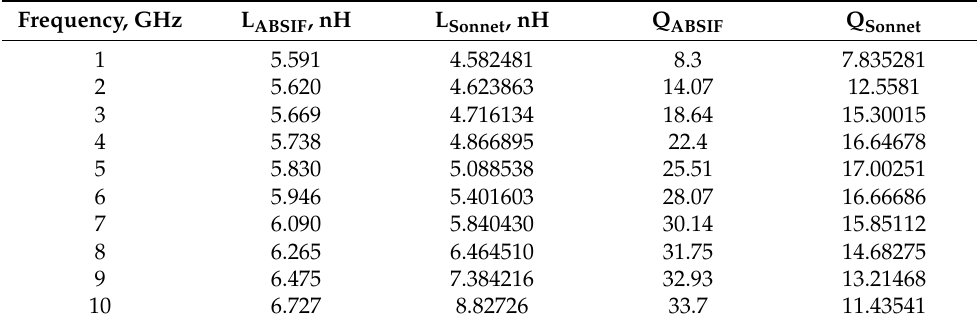
Table 6. L and Q vs. f for 2 turns spiral inductor at 4 GHz: comparison of the results obtained by ABSIF and Sonnet.